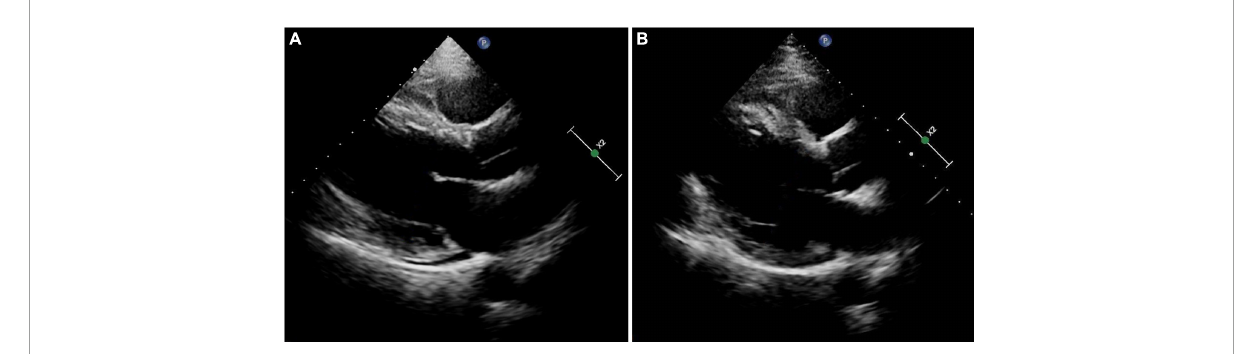
FIGURE1 Results of transthoracic echocardiography. (A) On admission. (B) At the 3-month follow-up.